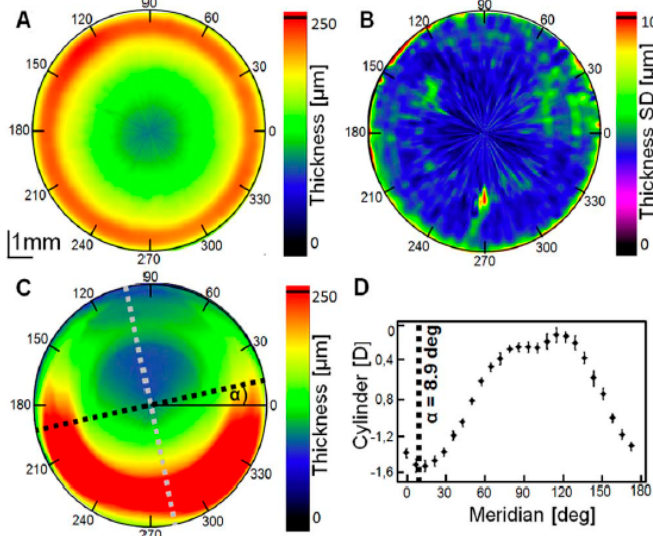
Figure 7. SSOCT of a CL’s measurable estimation. Averaged thickness map ( A ), standard deviation map of the thickness from 10 tests of the spherical soft CL ( B ), and thickness of the toric soft CL shown as maps ( C ); there is a brightly visible bottom weighting ballast with the axis rotated by α = 8.9 deg. Astigmatism of the toric soft CL ( D ). Adapted from Karnowski et al. [58]. The capabilities of OCT (a custom-built OCT system) have been extended to provide precise thickness evaluation and high-definition 3D imaging of the edge of the soft CL immersed in different environments [60].